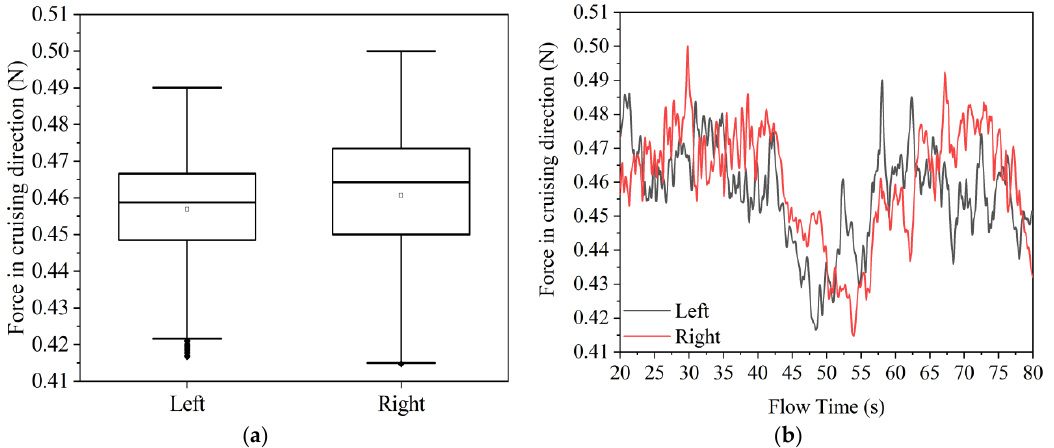
ratio of the front force decreases (Figure 6b,c). The lowest forces were obtained on the sides, which are magnified for the 20 km/h case in Figure 7.